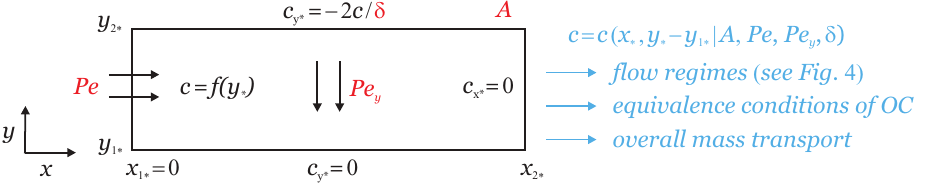
Figure 2. An illustration of the flow configuration considered and flow physics questions addressed (in blue). Operation condition parameters are given in red. Partial derivatives ( c x ∗ and c y ∗ ) are indicated here by